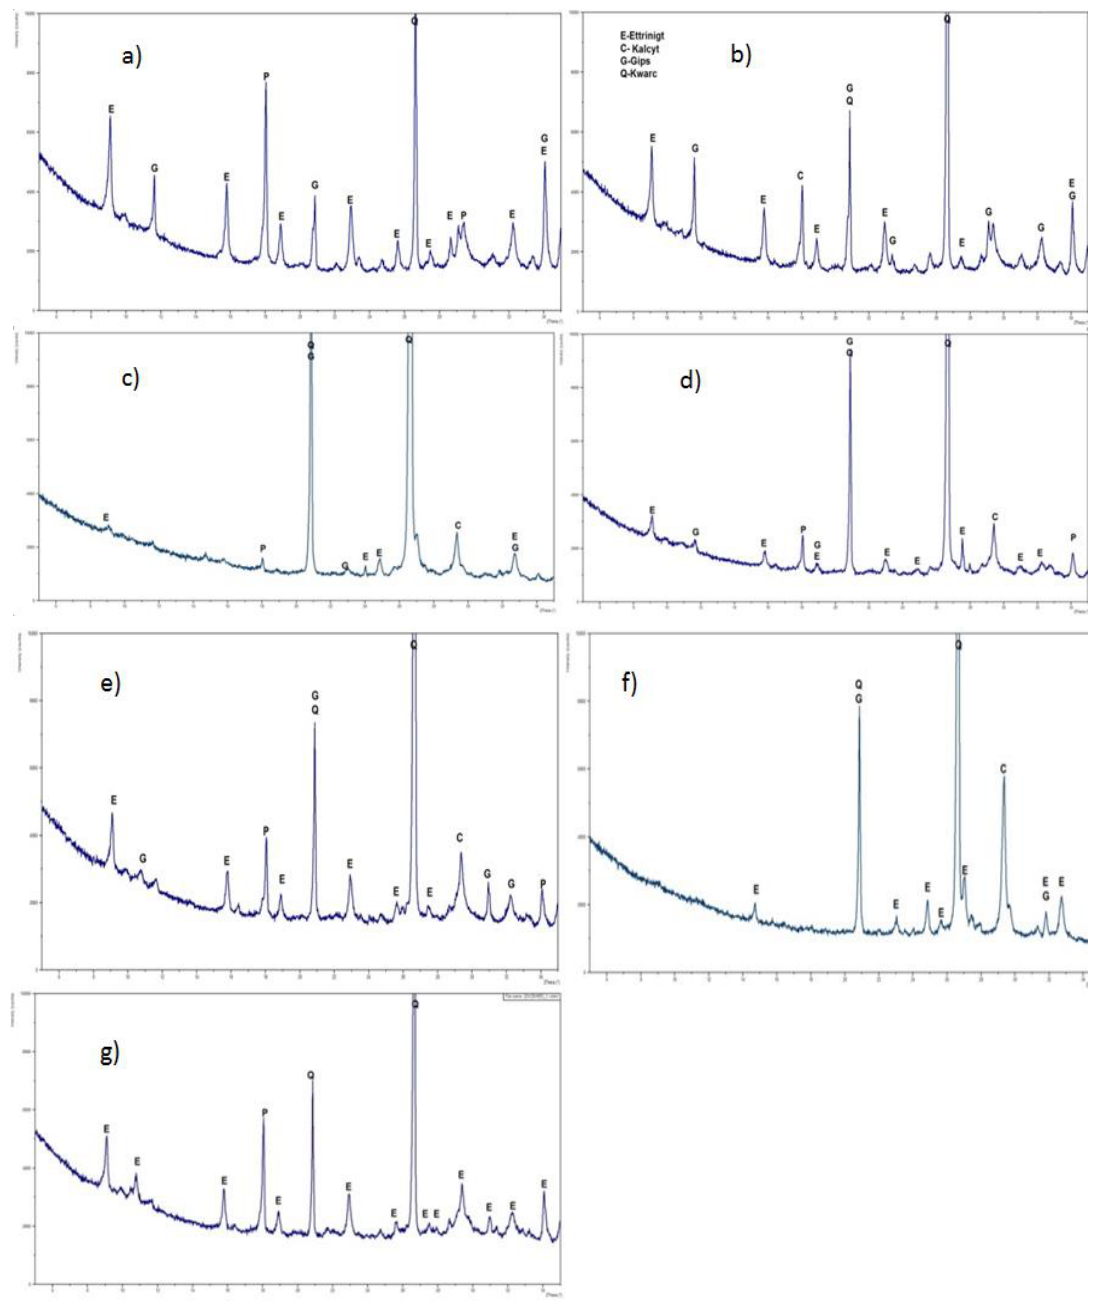
Figure 5: Diffraction pattern of mortars exposed to sodium sulphate (a) OPC mortar after 220 days in the solution, (b) M2-1 after 450 days, (c) M3-1 after 700 days, (d) M4-1 after 560 days, (e) M2-2 after 700 days, (f) M3-2 after 700 days, (g) M4-2 after 700 days in the